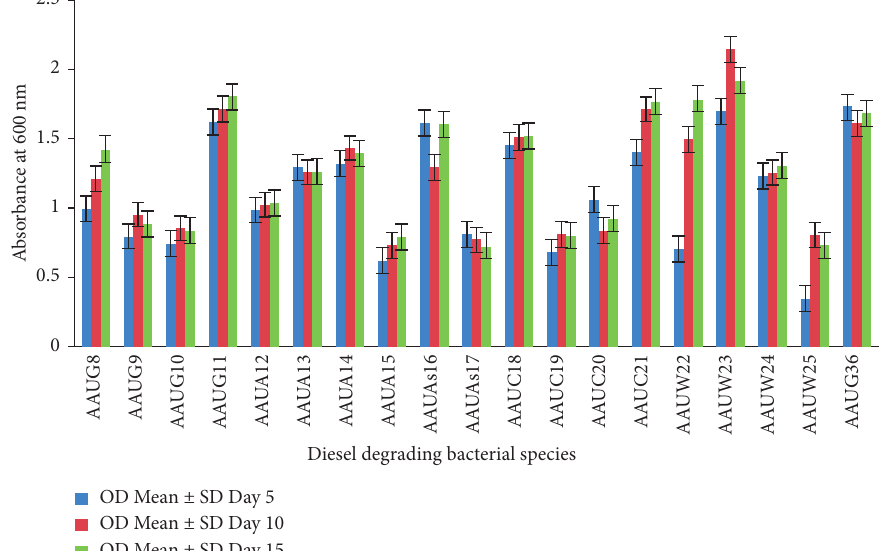
Figure 2: Growth capacity of isolates on diesel (3% concentration at different growth